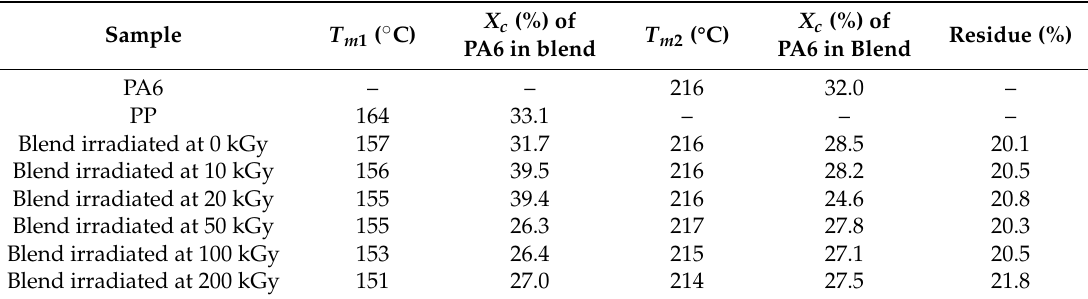
Table 1. Thermal properties of PA6, PP, and blends, and extraction result of blends.